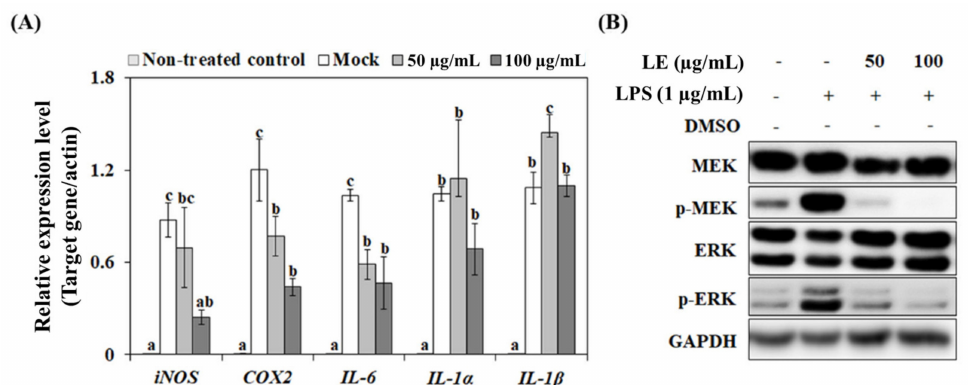
Figure 4. Molecular mechanisms of leaf extract (LE) in LPS-stimulated RAW 264.7 cells. ( A ) Effect of LE on the expression of LPS-induced pro-inflammatory mediators ( iNOS , COX-2 , IL-1 α , IL-1 β , and IL-6 ). The expression levels of each gene were normalized to actin. ( B ) Effect of LE on the LPS-induced MEK/ERK signaling pathway. Each protein was immunoblotted three times using independently prepared lysates. All values are reported as the mean ± SE. DMSO-treated samples were used as a mock control. Different letters indicate significant differences between groups ( p <